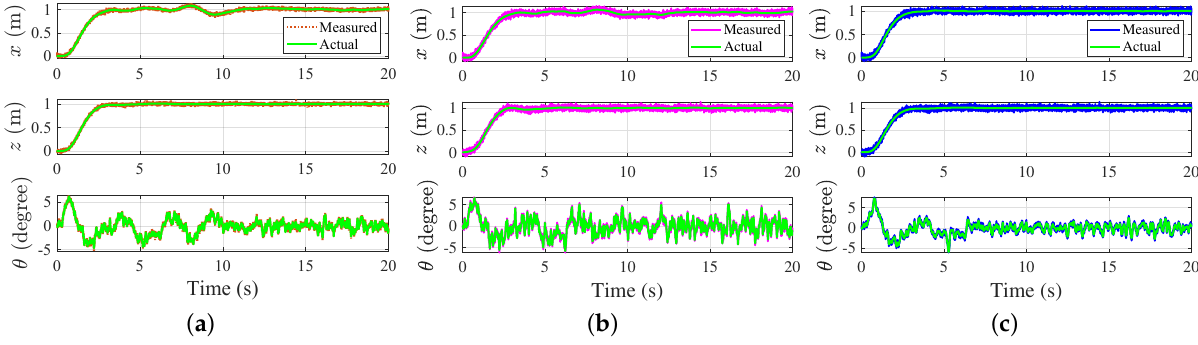
Figure 4. Comparison of measured and actual states for different approaches. ( a ) CPID; ( b ) IBC; ( c ) AIBC.